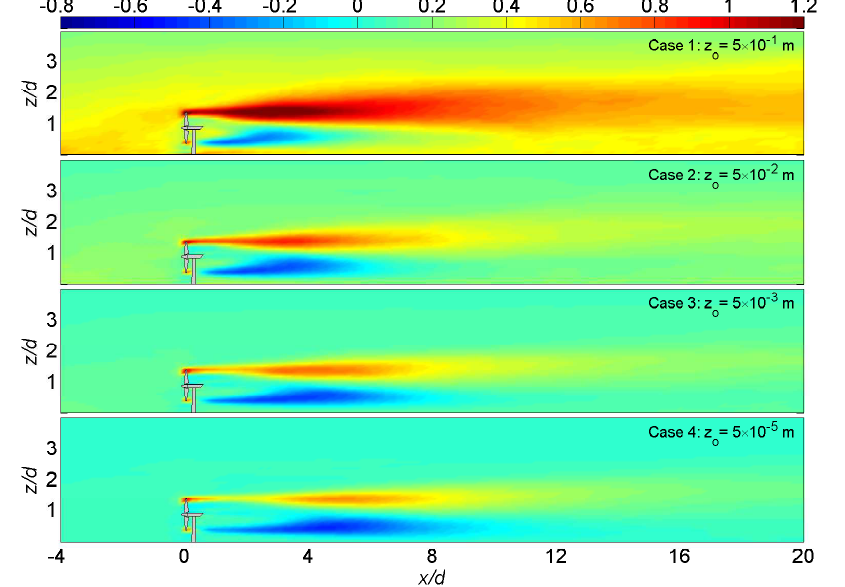
(m 2 s − 2 ) in the middle vertical plane xz